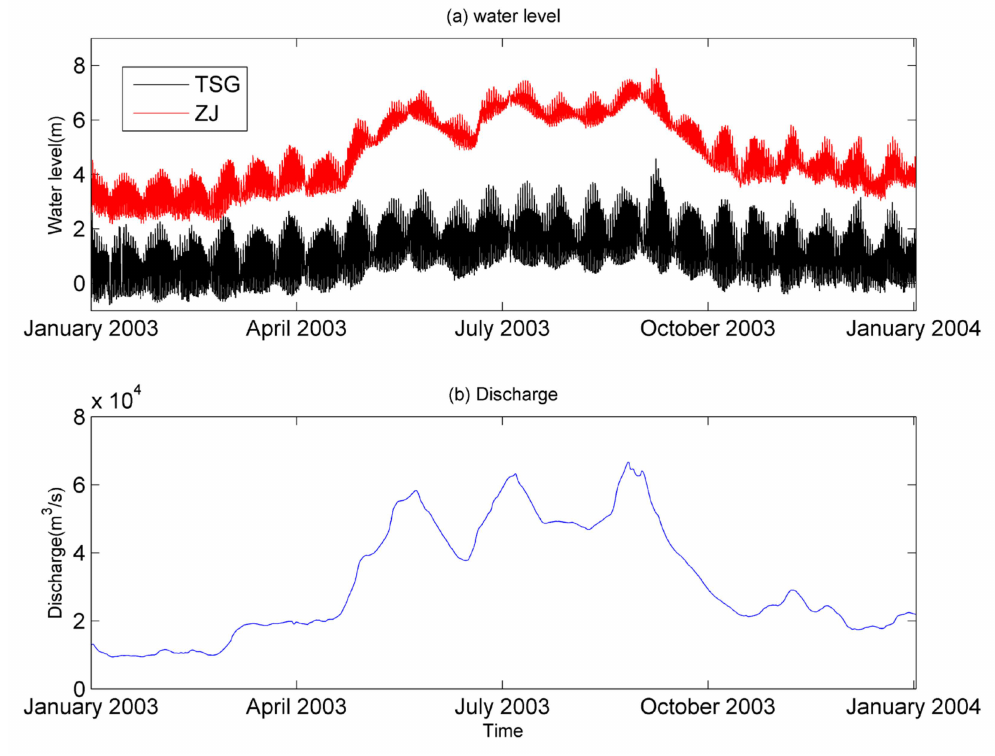
Figure 8. ( a ) Water levels at Tianshenggang (TSG) and Zhenjiang (ZJ). ( b ) Yangtze river discharge. Pelling et al. [11] discussed the impact of rapid coastline changes to the M 2 tide in the Bohai Sea and found that M 2 amplitudes changed up to 20 cm in some parts. Lu et al. [66] explored tidal propagation, tidal distortion, and tidal damping in the YRE during the dry season using Delft-3D [67]. Zhang et al. [68,69] explored the seasonal variation of a tidal prism and energy in the YRE via the TELEMAC-2D model [70]. They indicated that tidal discharge showed a noticeable decreasing trend with the increase of river discharge rate while the tidal storage volume was insensitive to river discharge. Zhang et al. [71] quantified the tide–surge interaction in the east coast of the Leizhou Peninsula, South China Sea via POM and pointed out that the largest amplitudes of the tide–surge interaction can reach 1 m during typhoon